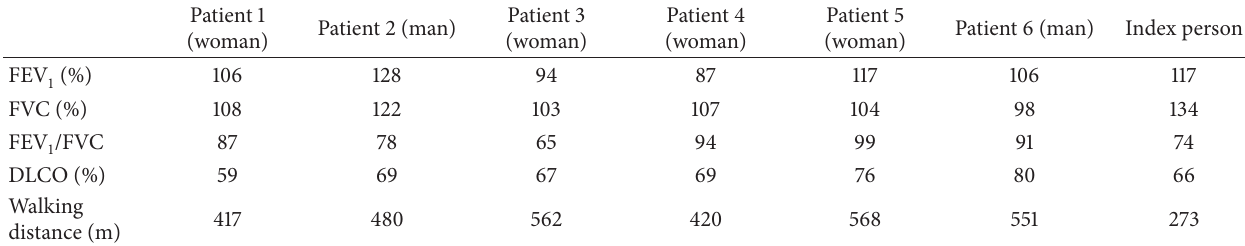
Table 1: Results of spirometry and body plethysmography, demonstrating forced expiratory volume in the 1st second in percent of